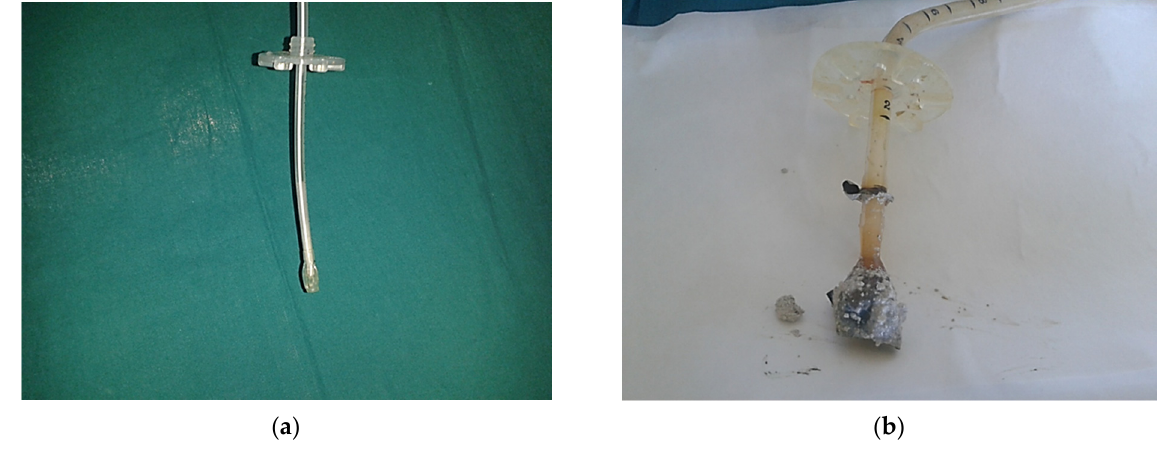
Figure 3. ( a ) Obstruction of a tube. ( b ) Obstruction of a PEG with breakage of the terminal bumper.